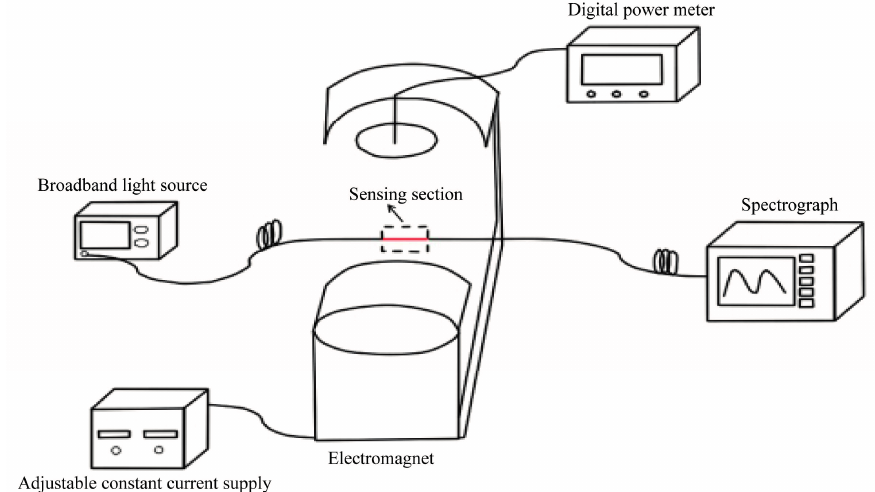
Figure 2. Experimental setup for investigating the magnetic field sensing properties of the MSM